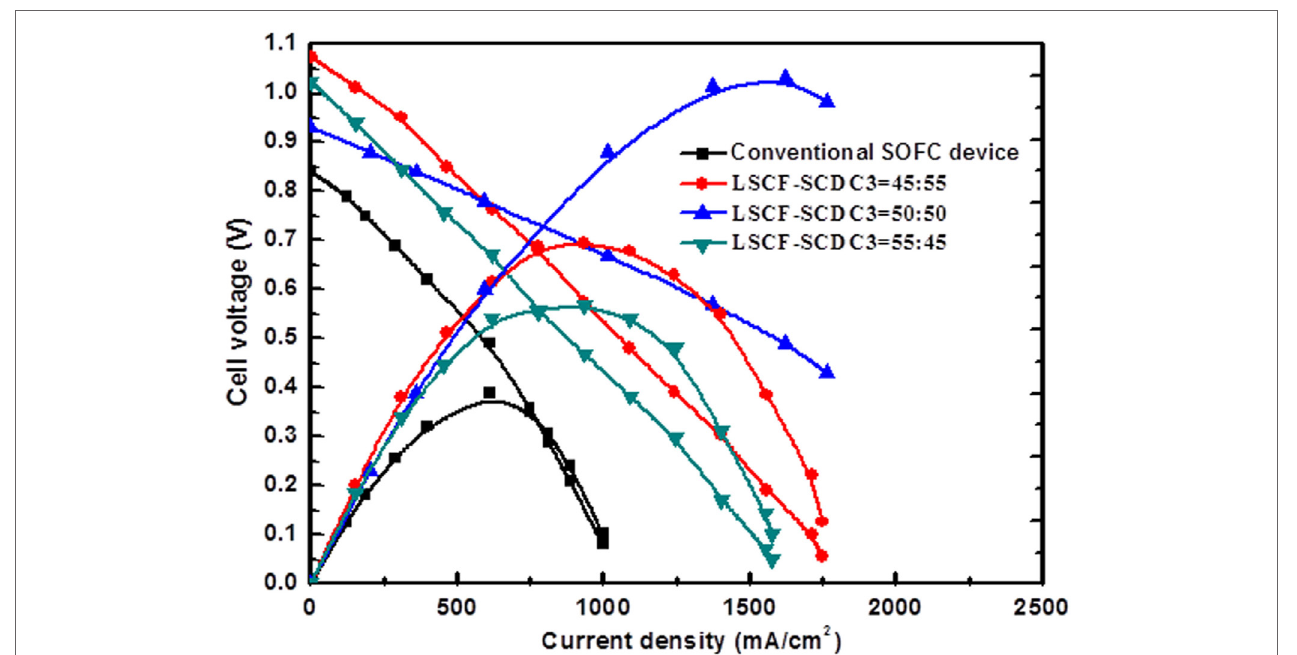
FiGURe 6 | Typical I – V and I – P characteristics for LSCF–SCDC fuel cells in comparison to the fuel cell using the ionic SCDC electrolyte .